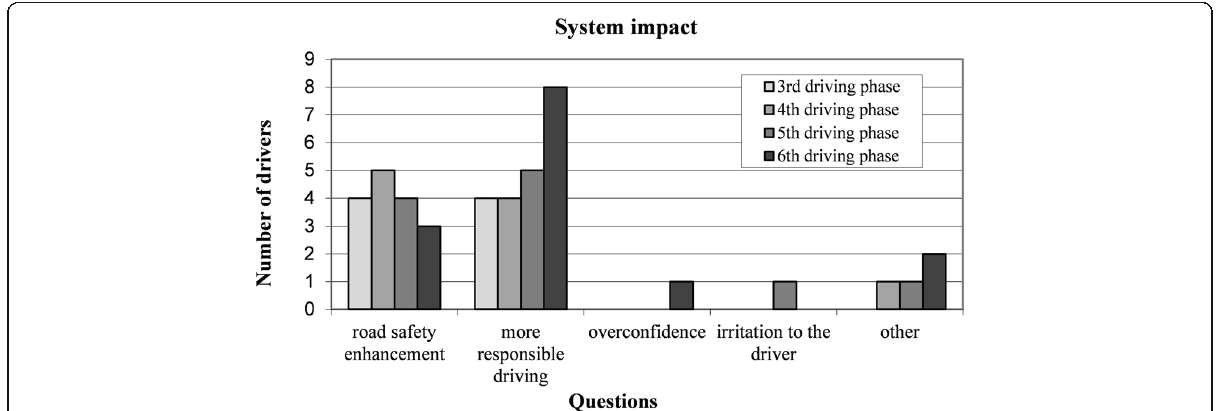
Fig. 3 Comparative results on the system impacts for the CAS, for the four driving